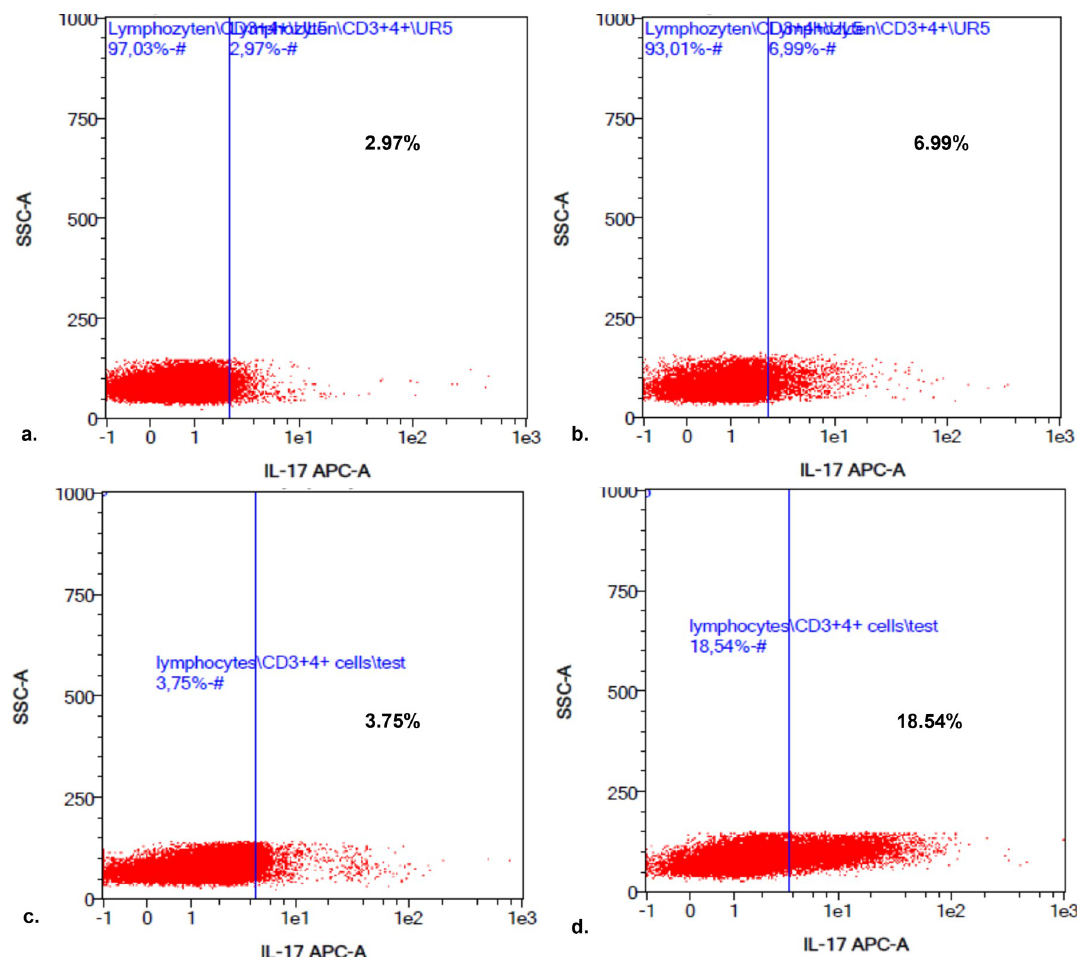
Fig 2. Presentation of a Th17 cell analysis after flow cytometry by MACSQuant Analysis Software of a healthy dog in comparison to a dog with IE. The pictures represent the results of Th17 cell analysis using MACSQuant analysis software (a.-d.). The left-sided upper box (a.) showing percentage of unstimulated Th17 cells in percentage of one dog of C, the left-sided lower box (c.) showing percentage of unstimulated Th17 cells in percentage of one dog with IE. The right-sided boxes (b. and d.) showing corresponding stimulated Th17 cells in percentage of the dogs of a. and c. Therefore, box b. showing the stimulated Th17 cells in percentage of the dog of C and d. of the dog with IE (c.). There is no big difference in the number of unstimulated Th17 cells (2.97% versus 3.75%) but in the amount of stimulated Th17 cells of dogs with IE in comparison to the C (6.99% versus 18.54%). Caution should be given that results of the MACSQuant analysis software were displayed in percentage. For comparative analyses absolute numbers of Th17 cells/ μ L were used. Abbreviations: C: control group; IE: idiopathic